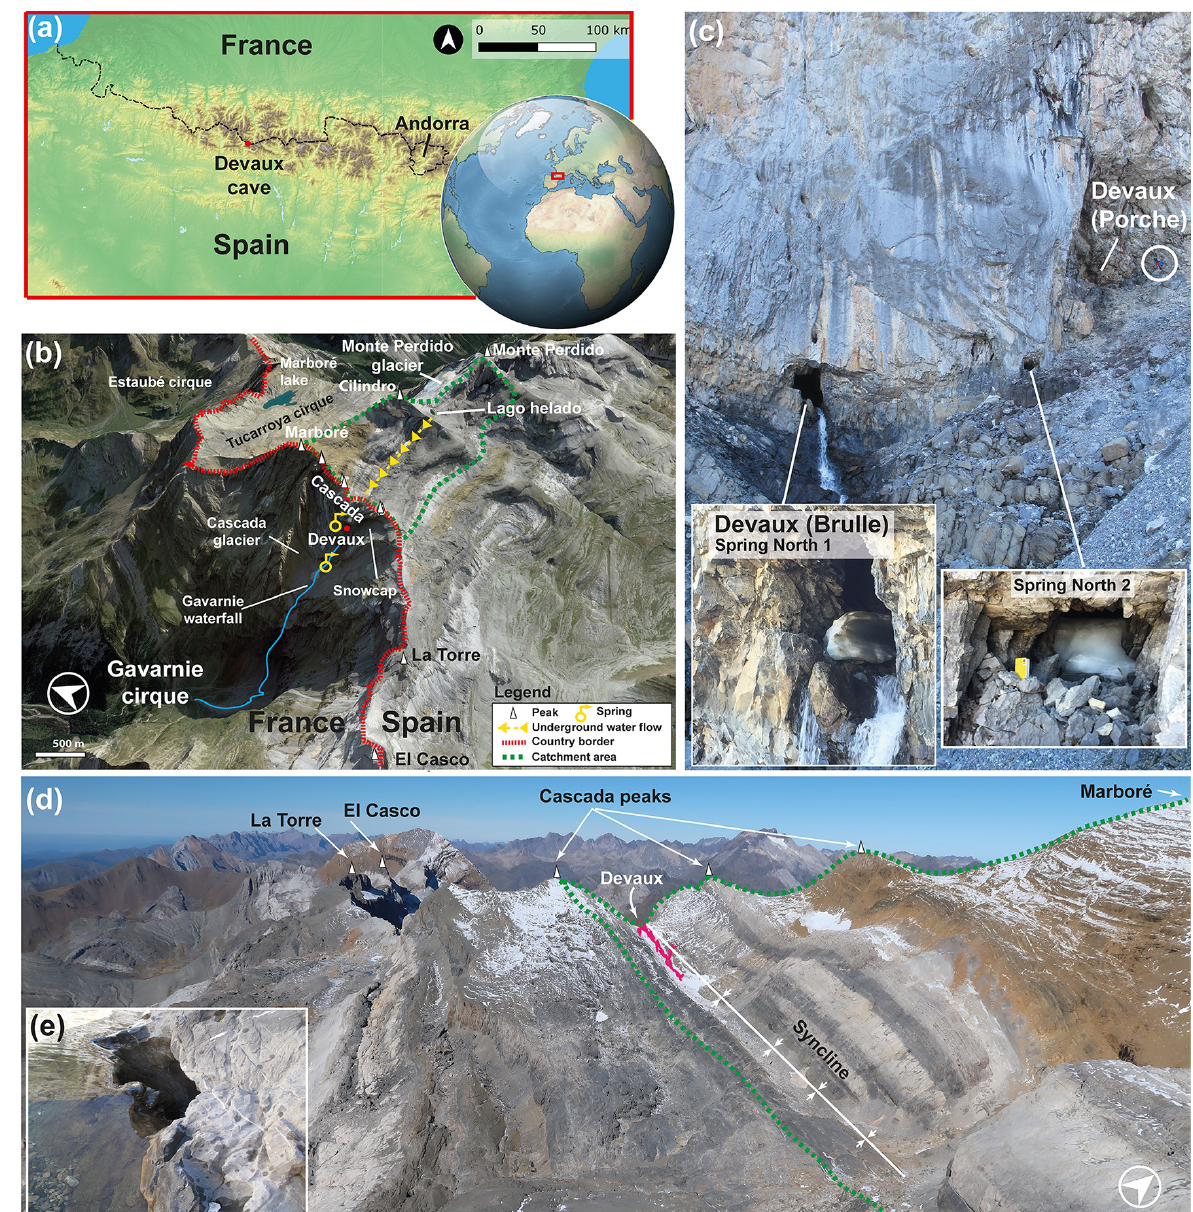
Figure 1. (a) Location of Devaux cave in the Central Pyrenees (ASTER GDEM, NASA v3, 2019). (b) Satellite image and location of Devaux cave, main peaks, lakes, glaciers, and cirques in the study area (3D © Google Earth). The yellow arrows indicate the underground flow path from Lago Helado to the Gavarnie waterfall according to the dye-tracing experiment of du Cailar et al. (1953). (c) View towards the entrances of Devaux cave. The lower entrance ( ∼ 2821ma.s.l.) corresponds to the Brulle spring (Spring North 1), while the upper one corresponds to the main entrance (Porche (South), ∼ 2836ma.s.l.). Spring North 2 is located between both entrances. Note person for scale (within the white circle). Remnants of ice partially blocking Brulle and Spring North 2 (July 2021). (d) Landscape view of the catchment area and approximate location of Devaux cave (in dark pink; photo: Paul Cluzon). (e) Ponor located on the southern shore of Lago